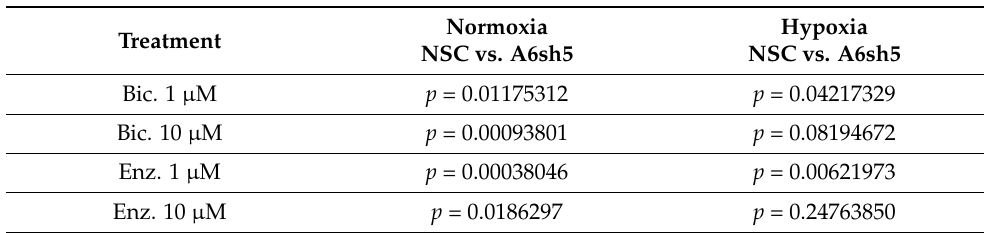
Table 2. Statistical significance of AnxA6 downregulation on the response to AR antagonist under